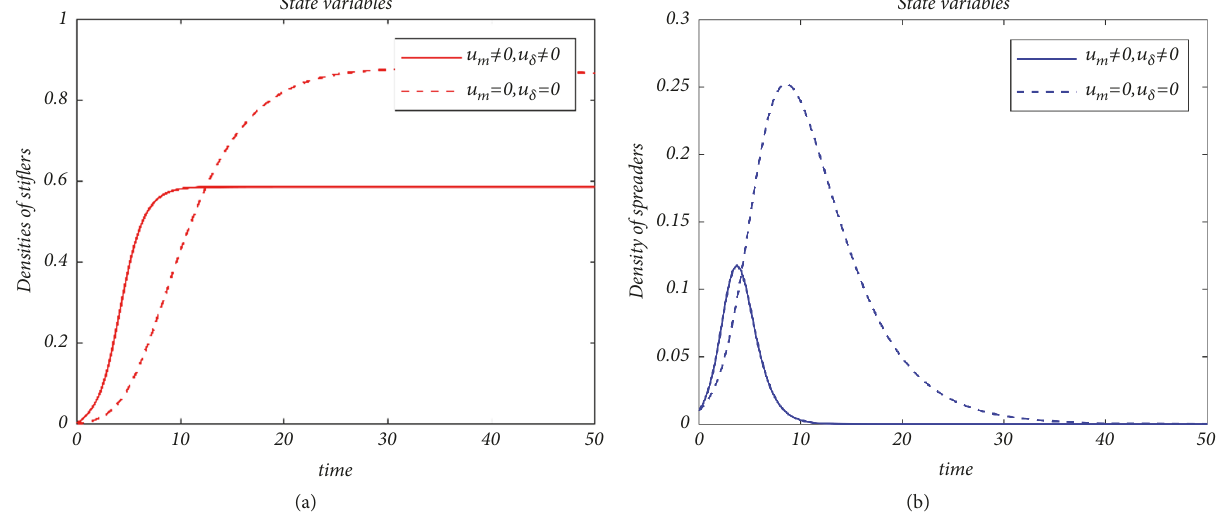
Figure 5: Evolution of densities of spreaders and stiflers with control or without control.